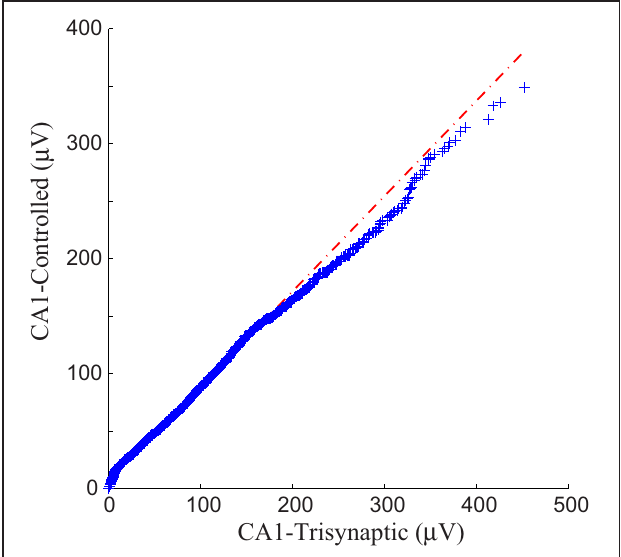
FIGURE 8 | A Q–Q plot demonstration of the data comparison between the trisynaptic CA1 responses and the paradigm controlled CA1 responses.